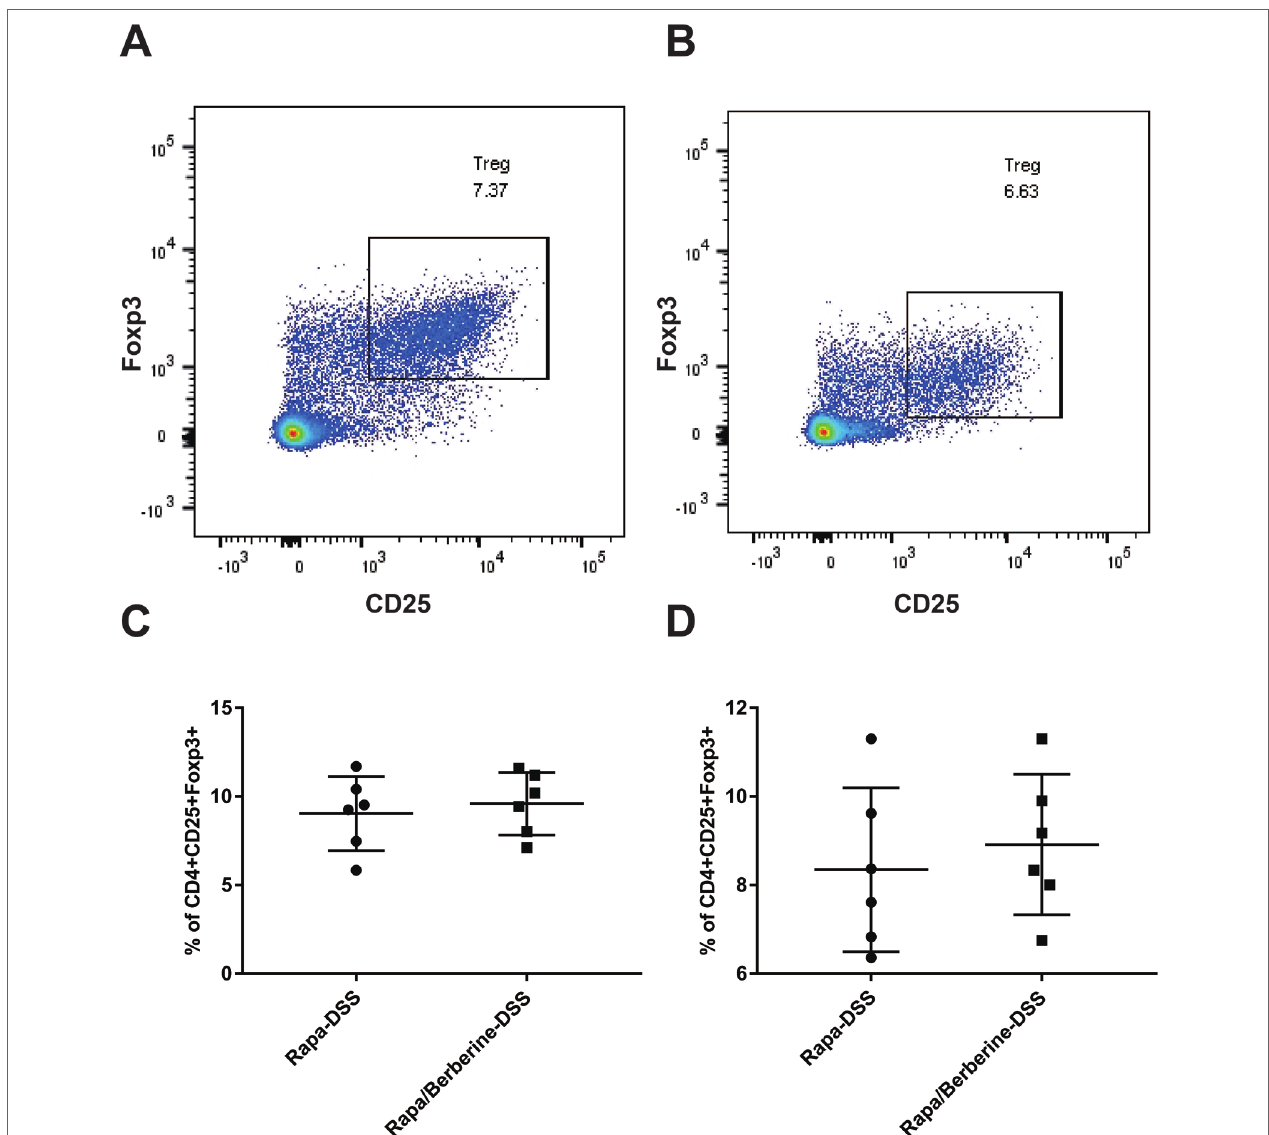
FIGURE 8 | Effects of berberine on the proportion of Treg when rapamycin was used to inhibit mTORC1 signaling. The proportion of Treg in MLNs and spleens was evaluated by flow cytometry. (A and C) Tregs in MLNs ( n = 6). (B and D) Tregs in spleens ( n =